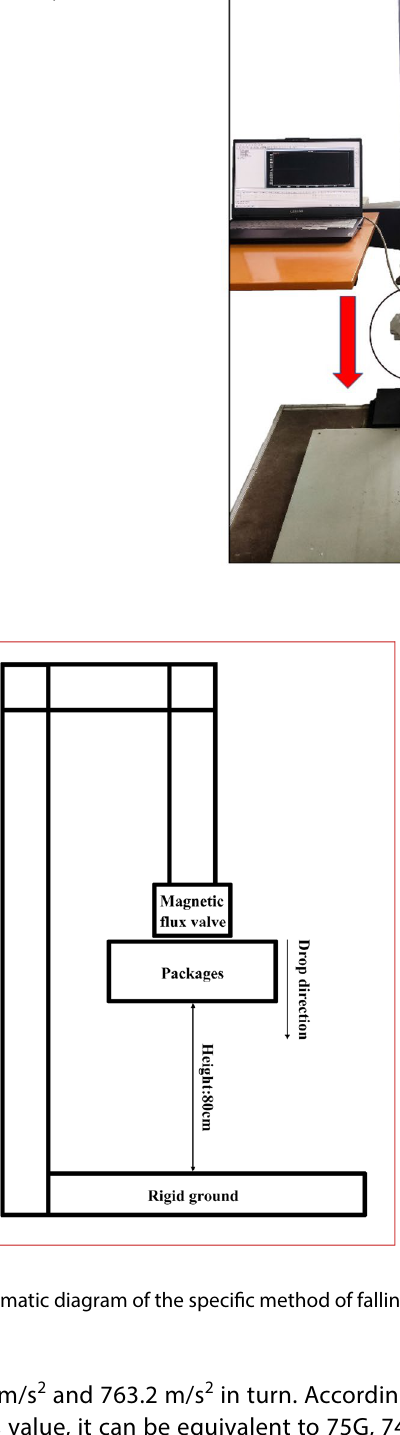
Fig. 14 Drop test system